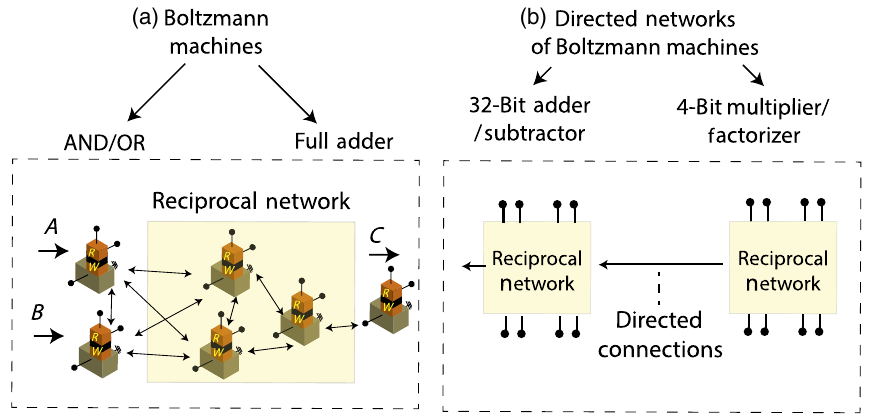
FIG. 2. PSL designs discussed in this paper. (a) Basic Boolean elements (AND and OR, full adder) are implemented as Boltzmann machines based on symmetrically coupled networks with J ij ¼ J ji . (b) Complex Boolean functions like a 32-bit ripple carry adder or subtractor and 4-bit multiplier or factorizer are implemented by combining the reciprocal Boltzmann machines in a directed